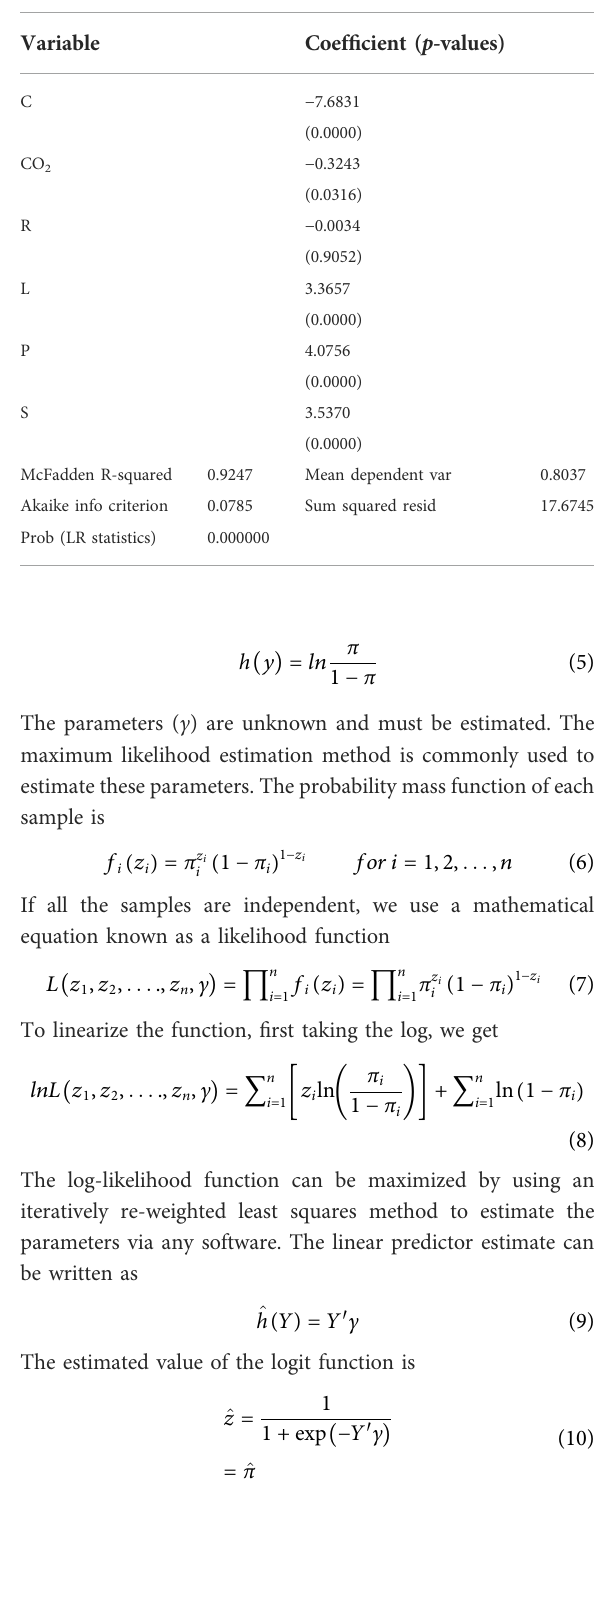
TABLE 1 Logistic regression